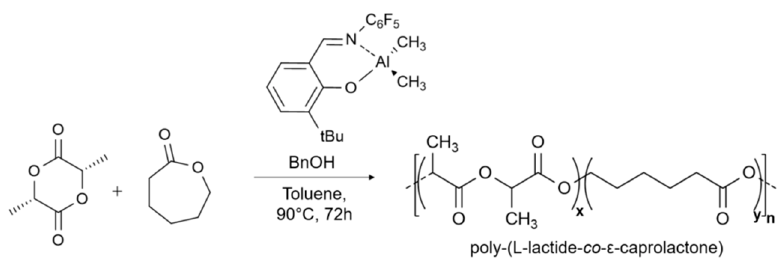
Table 1. Copolymerization of caprolactone and lactides catalyzed by complex